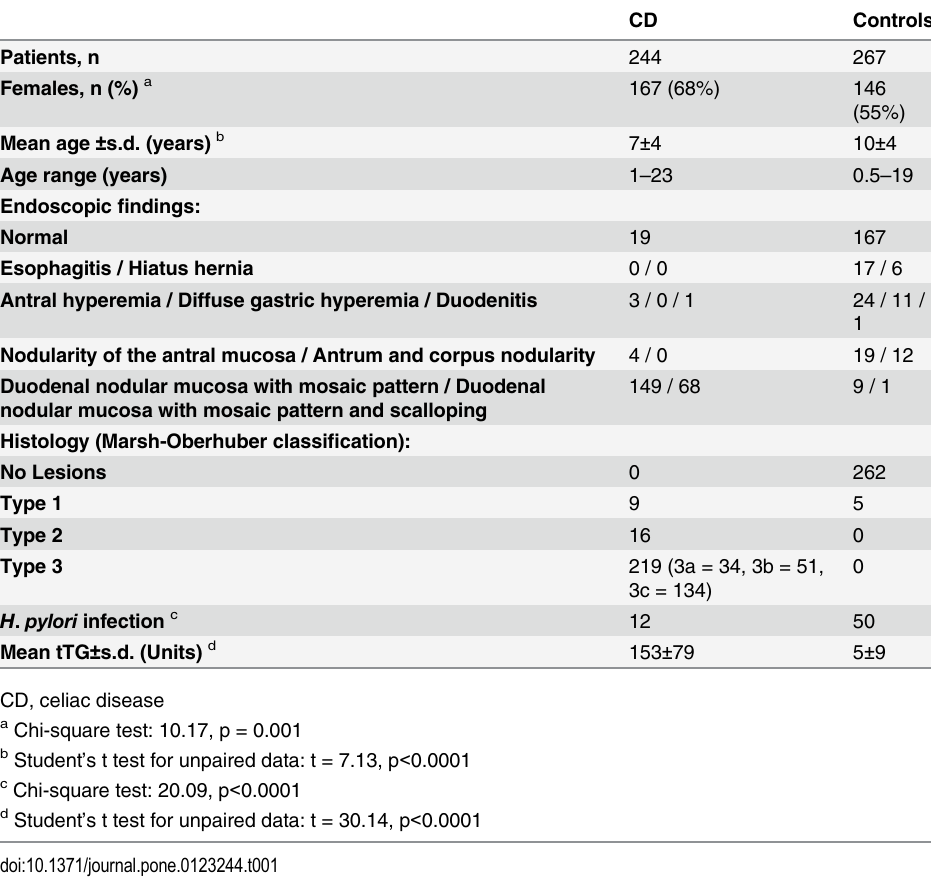
Ferstlet al. [35]. Homozygous status was evaluated for the HLA-DQB1 (cid:1) 02 allele by the set up of RT-PCR reactions to detect most of the already known HLA-DQB1 alleles different from (cid:1) 02 [35]. Primers and probes were aligned with sequences reported in the IMGT/HLA database (Monza, Italy). The analyses were made starting with about 100 ng DNA in a final volume of